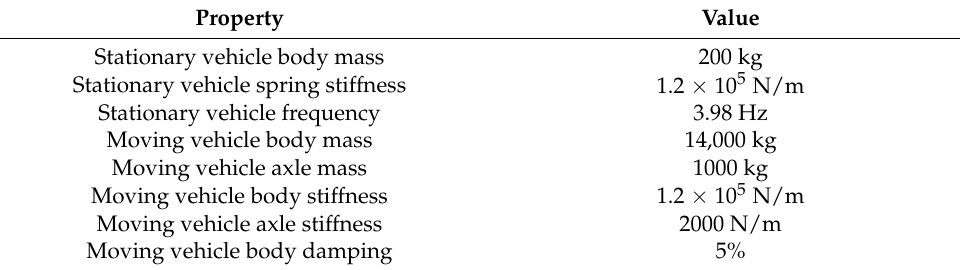
Table 2. Properties of the moving and stationary